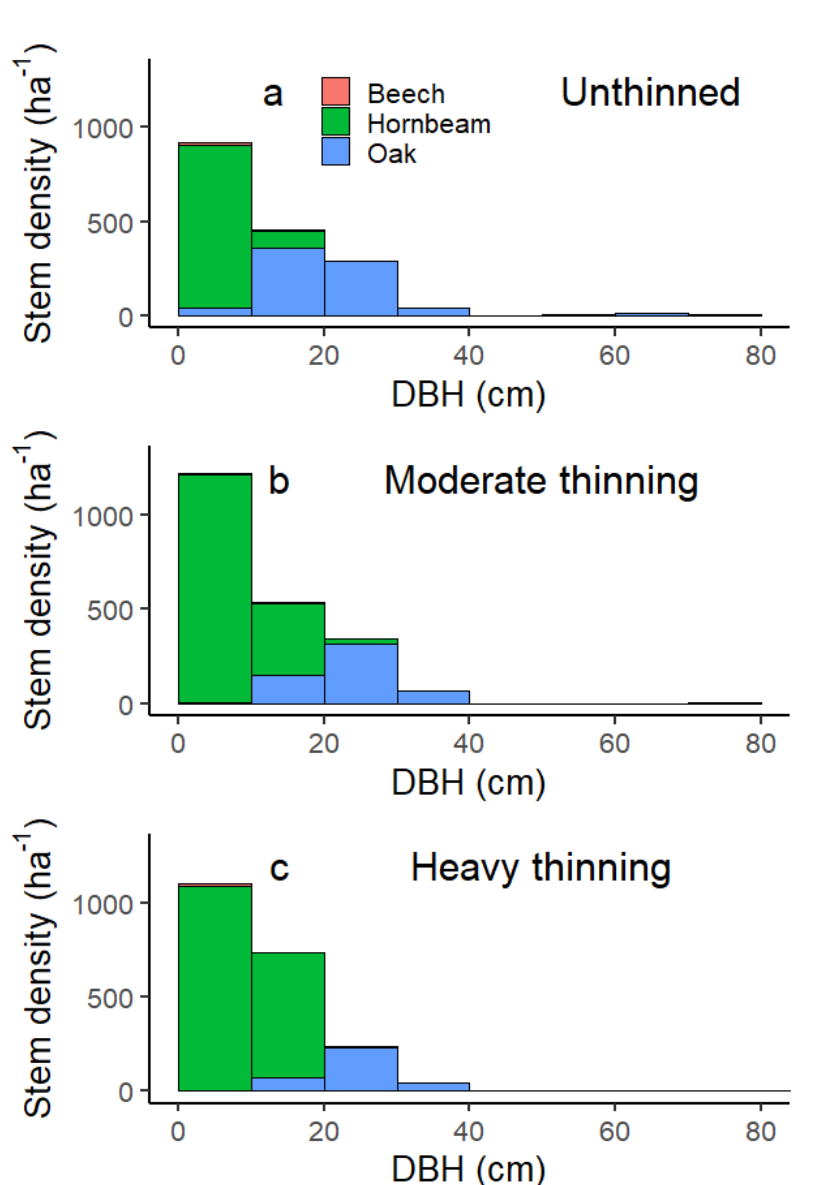
Figure A3. ( a ) Stem density in 2009 before thinning grouped into 10 cm DBH classes with colour ‐ coded species. ( b ) Oak includes sessile oak Quercus petraea and Turkey oak Quercus cerris , ( c ) European hornbeam Carpinus betulus , European beech Fagus sylvatica .